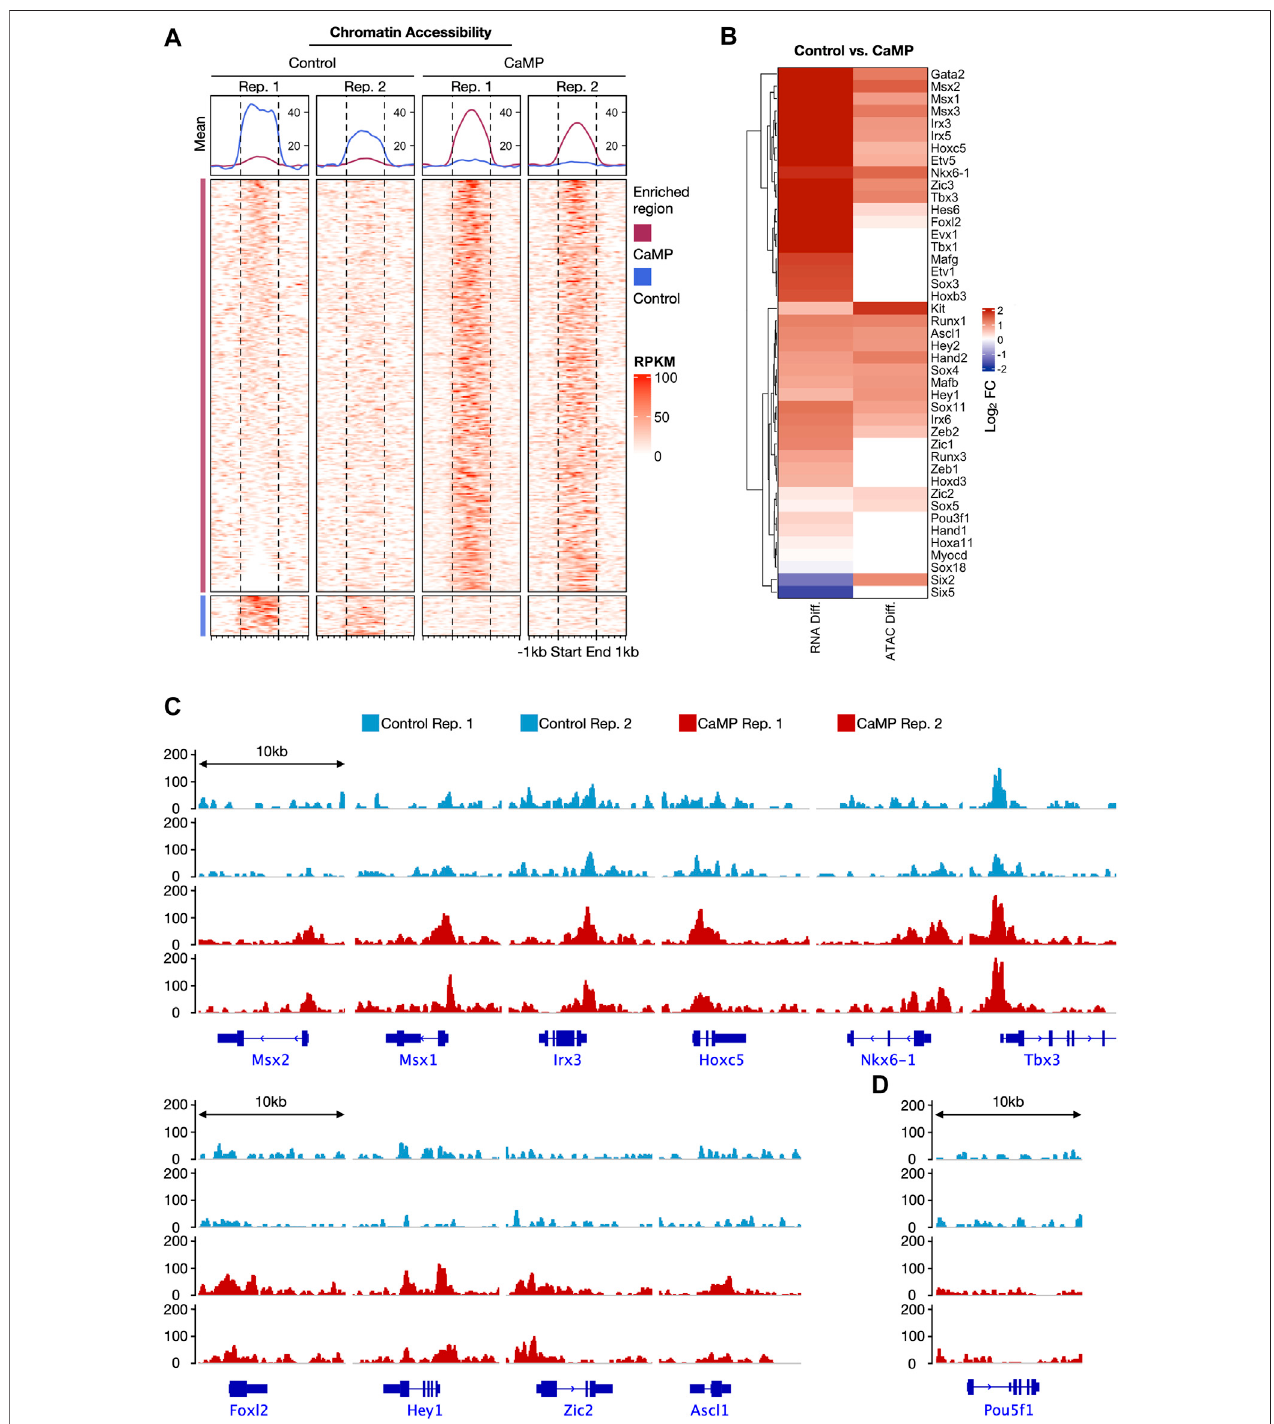
FIGURE3| ChemicalsinducedaglobalgainofchromatinaccessibilityatCaMPphaseasearlyasday4. (A) Comparisonofchromatinaccessibilitysignalsdetected by ATAC-seq between Control and CaMP samples at day 4. Differential peak regions are shown with ±1 kb extension. The peak region signals were normalized with RPKMandclusteredinto “ Controlenrichedregion ” and “ CaMPenrichedregion. ” TheabovepanelsshowthemeanRPKMvalueofcorrespondingcolumnsandclusters. Both Control and CaMP conditions have two biological repeats. (B) Gene expression changes (RNA Diff.) and chromatin accessibility level changes (ATAC Diff.) of three germ layer master genes after 4 days of treatment of C6FAE compared with MEF. Different levels are quanti fi ed with the difference of log 2 (FPKM+1) and log 2 (RPKM+1), respectively. (C) ATAC signal visualization of representative activated TFs with enhanced chromatin accessibility. RPKM range shown is scaled to the same among the four samples. (D) ATAC signal visualization of the pluripotency marker gene, Pou5f1 . RPKM range shown is scaled to the same among the four samples.